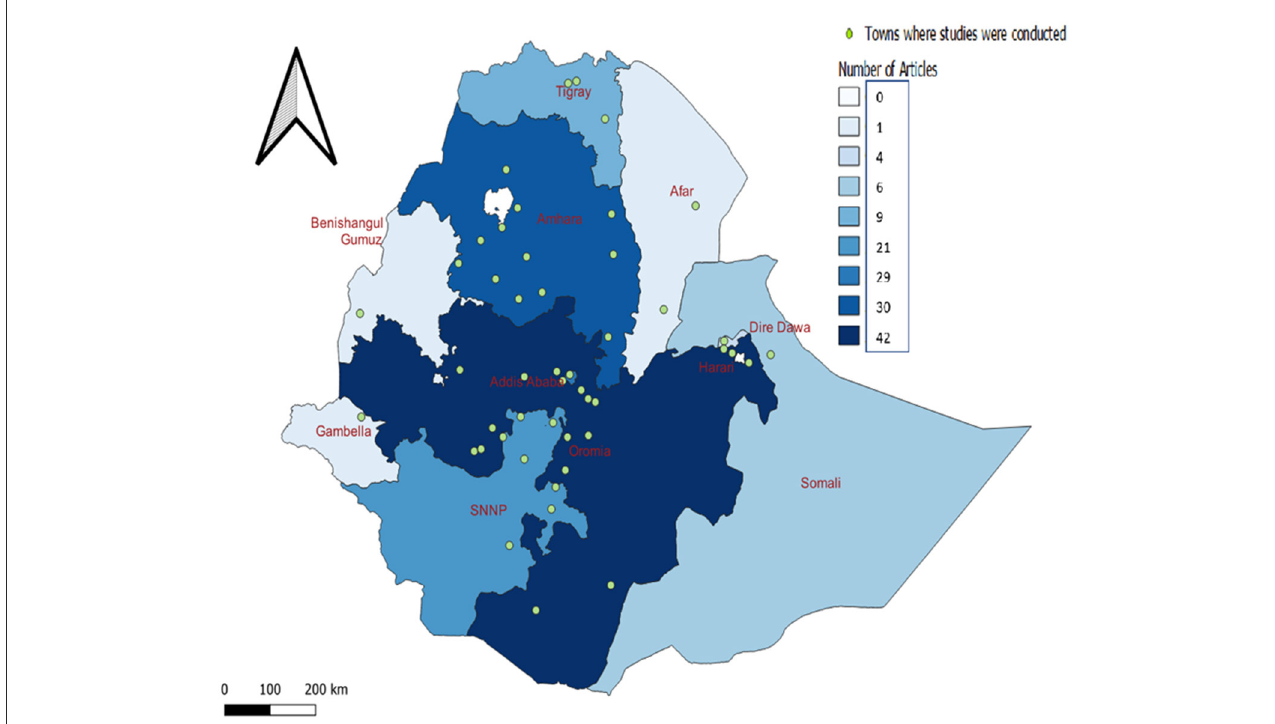
FIGURE2 Spatial distribution of regions and towns where the studies were conducted. Concentration of included studies over regions in Ethiopia with dark blue color indicating the highest number of articles and light blue representing fewer number of articles. The green circle dots indicating the towns where the studies were conducted.